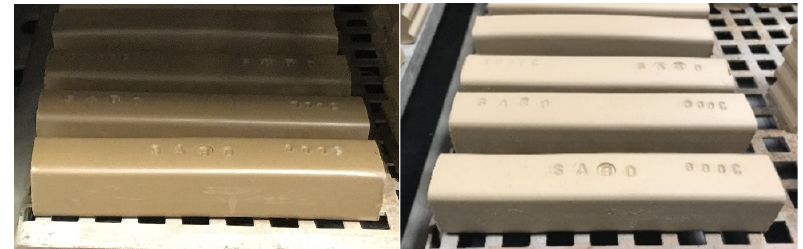
Figure 6. Samples placed in the laboratory dryer before and after the drying procedure.